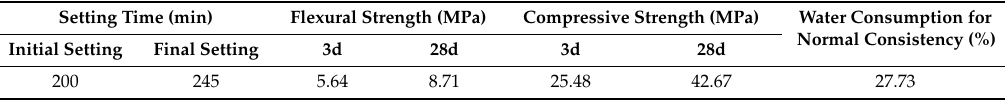
Table 1. Physical indexes of cement.